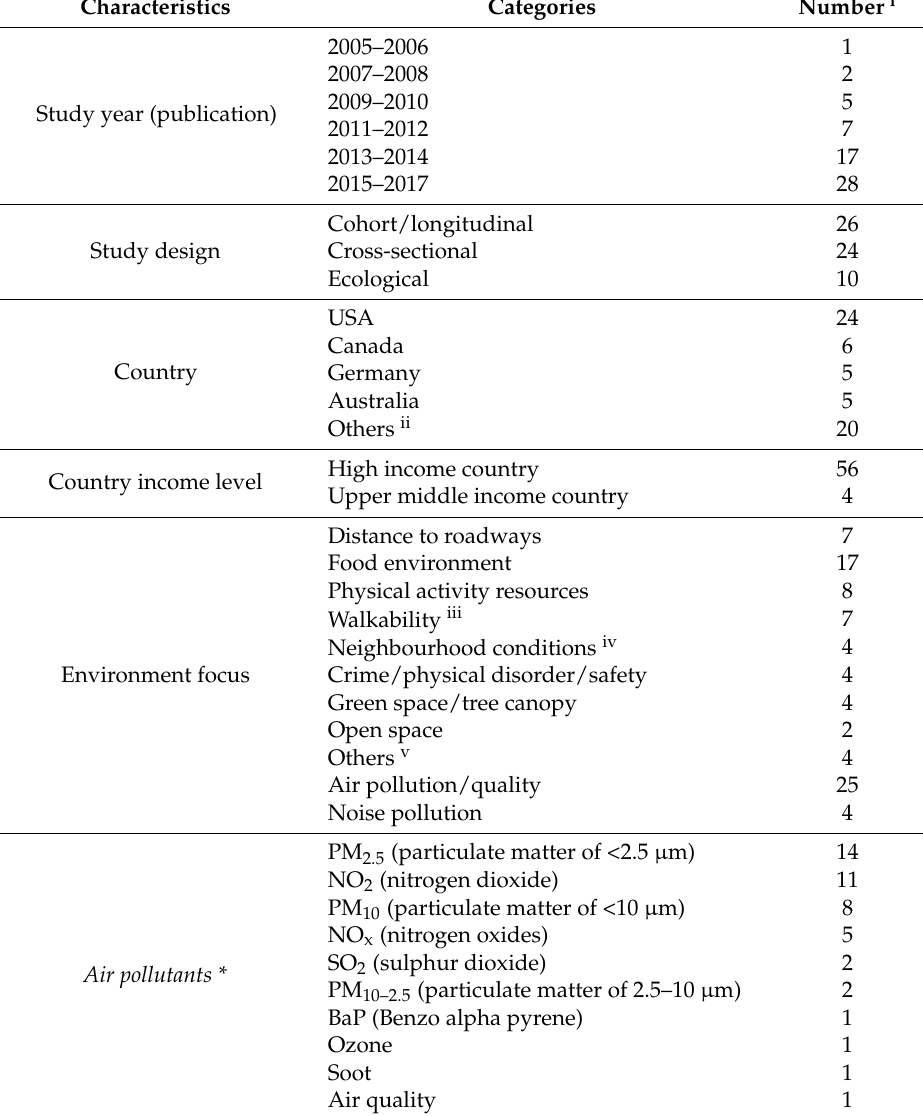
Table 2. Summary of studies